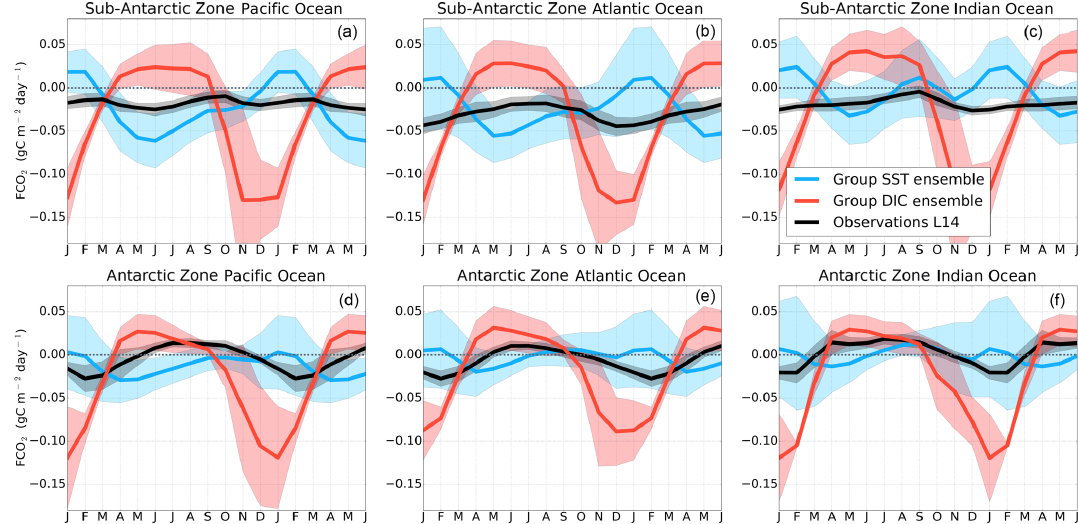
Figure 3. Seasonal cycle of the equally weighted ensemble means of F CO 2 (gCm − 2 yr − 1 ) from Fig. 2 for group DIC models (MPI-ESM, HadGEM-ES and NorESM) and group SST models (GFDL-ESM2M, CMCC-CESM, CNRM-CERFACS, IPSL-CM5A-MR, CESM1-BGC, NorESM2, MRI-ESM and CanESM2). The shaded areas show the ensemble standard deviation. The black line is the Landschützer et al. (2014)